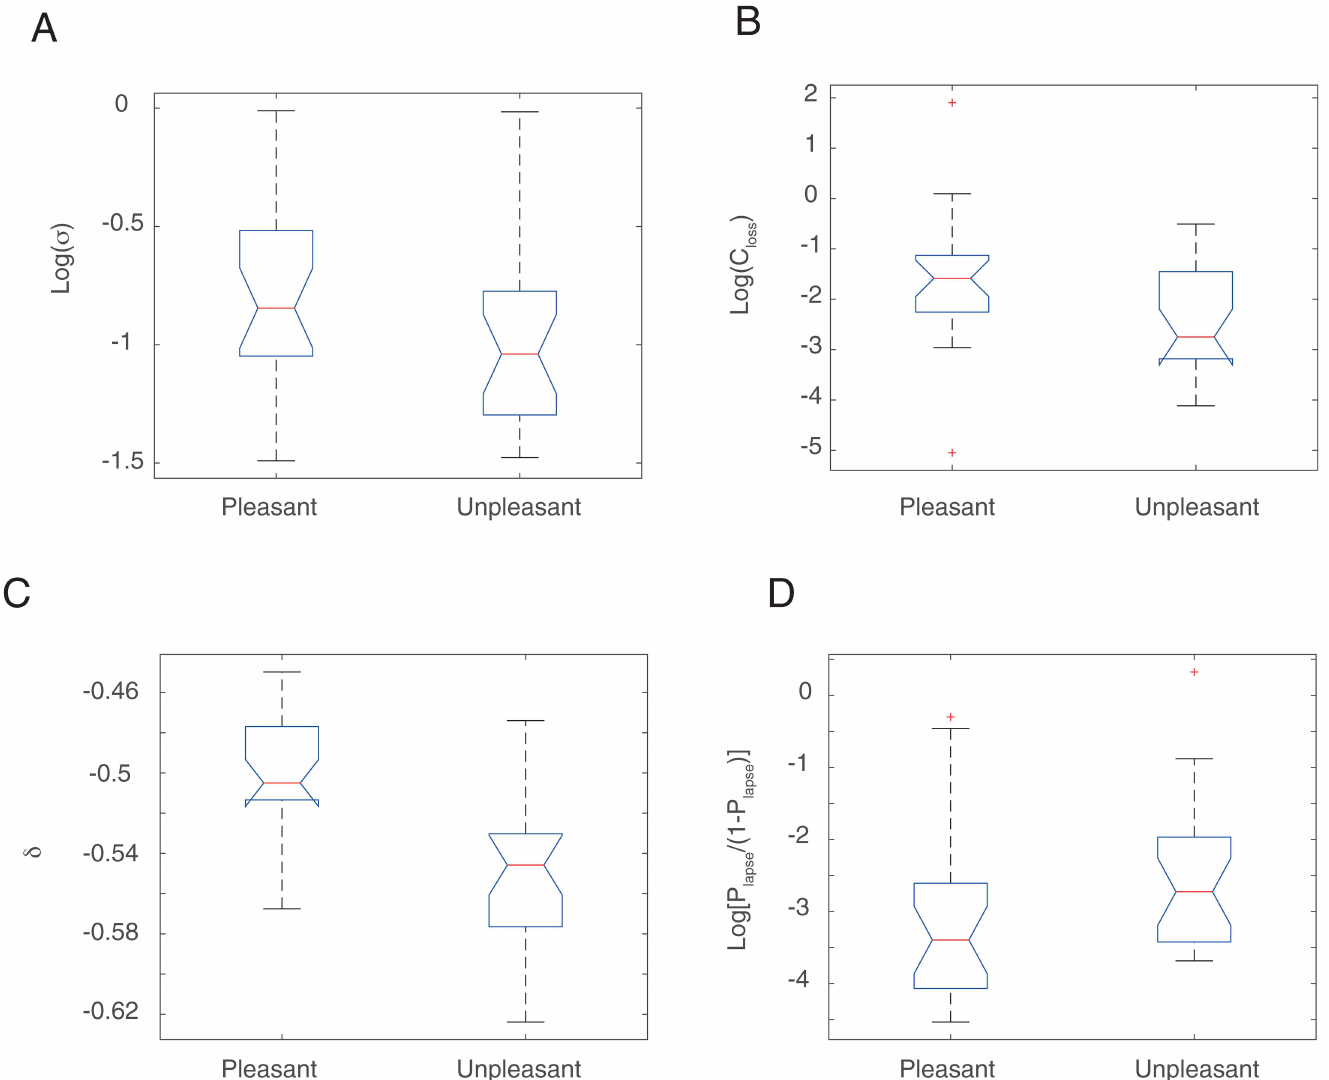
Fig 7. Estimated parameters of the four parameter model in Session 3. A . The noise parameter σ . The means of Pleasant and Unpleasant room participants were not significantly different. B . The relative weight of losses to wins. The means of Pleasant and Unpleasant room participants were significantly different. C . The bias parameter δ . The means of Pleasant and Unpleasant room participants were significantly different. D . The lapse rate. The means of Pleasant and Unpleasantroom participants were mildly significantly different. The parameters are shown in the inference